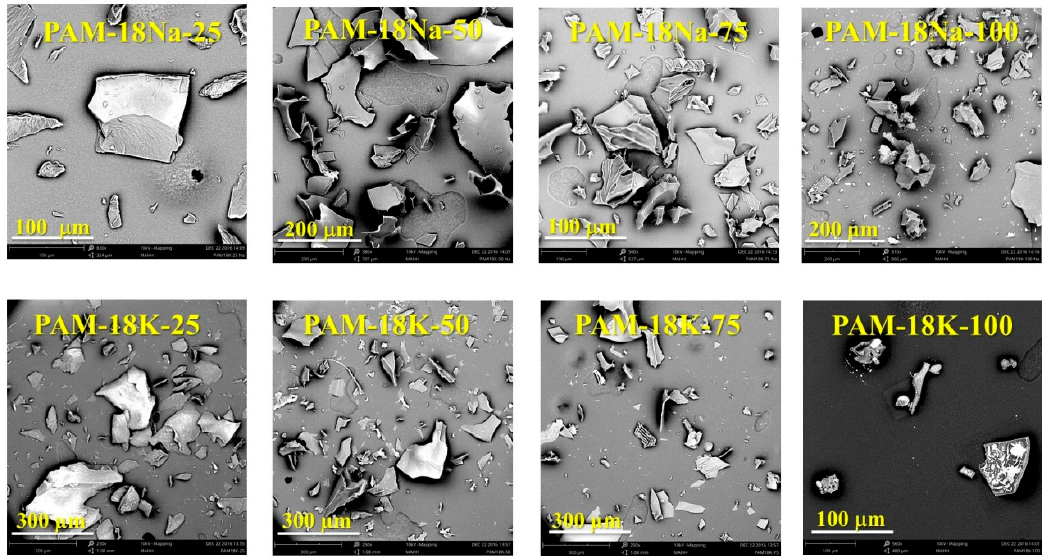
Figure 6. SEM images of polymers derived from PAM-18.